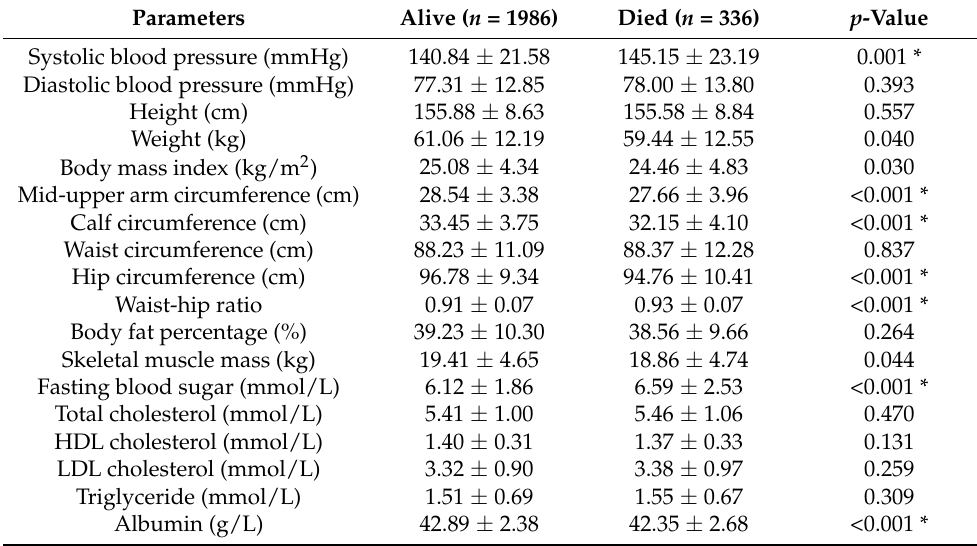
Table 3. The baseline vital signs, anthropometry measurements and health profiles of respondents who were alive or died after five years [presented as mean ± standard deviation (sd)].